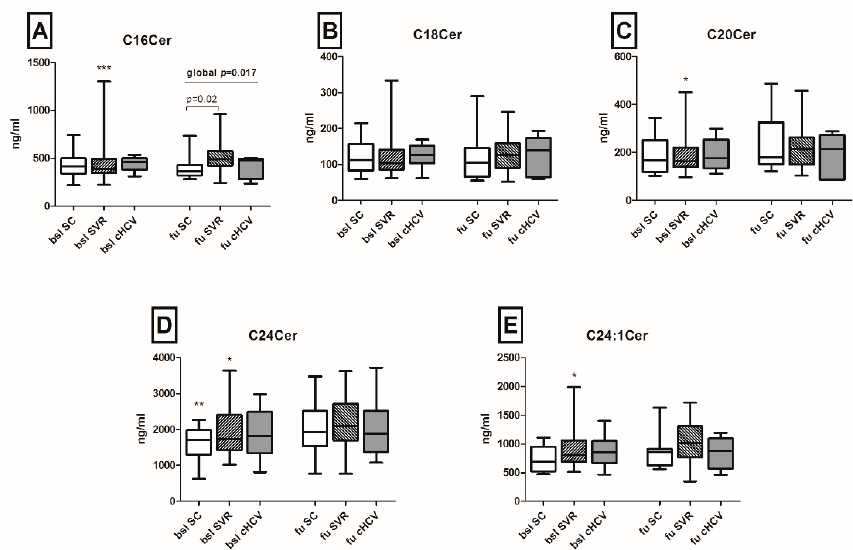
Figure 2. Serum dihydroceramide concentrations during acute HCV infection. C16DHC levels on follow-up were significantly lower in patients with spontaneous HCV clearance (( A ), p = 0.02), while levels of C24DHC and of its saturated derivative C24:1DHC increased longitudinally in patients with subsequent SVR after antiviral treatment (( C , D ), respectively, ** p < 0.01). No significant variations of C18DHC levels were observed both between patient groups and between baseline and follow-up ( B ). Statistical significance between baseline and follow-up is indicated by asterisks (*). DHC: dihydroceramide; SC: spontaneous clearance; SVR: sustained viral response; BSL: baseline; FU: follow-up; cHCV: chronic HCV.